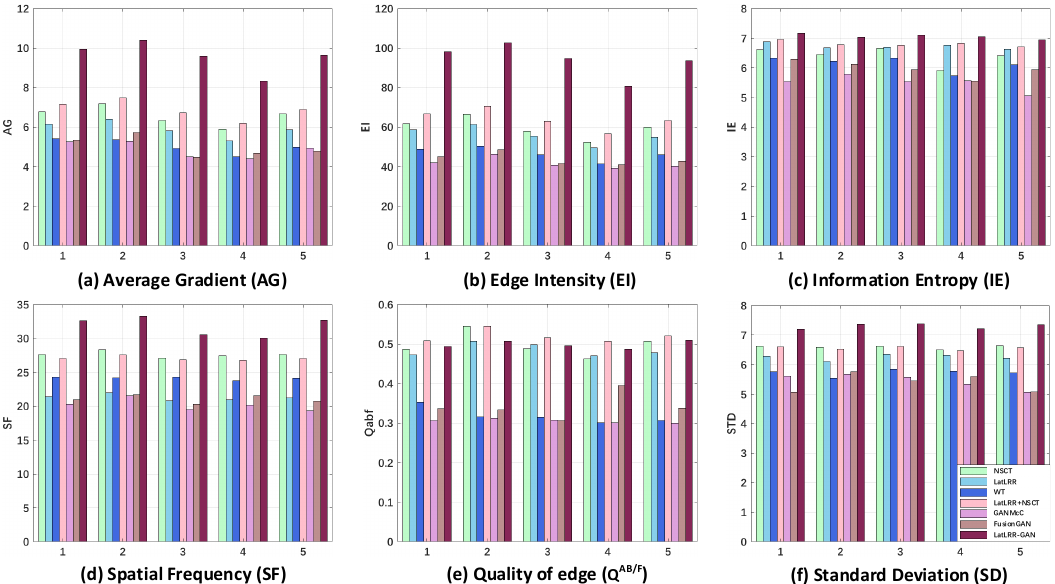
Figure 4. Bar charts of fused images’ evaluation metric values of CT lung window images and PET images. Method 1: NSCT; Method 2: LatLRR; Method 3: WT; Method 4: LatLRR+NSCT; Method 5: GANMcC; Method 6: FusionGAN; Method 7: LatLRR-GAN.